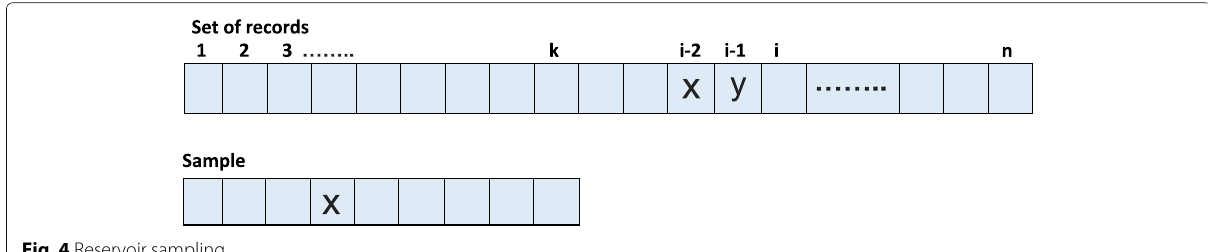
Fig. 4 Reservoir